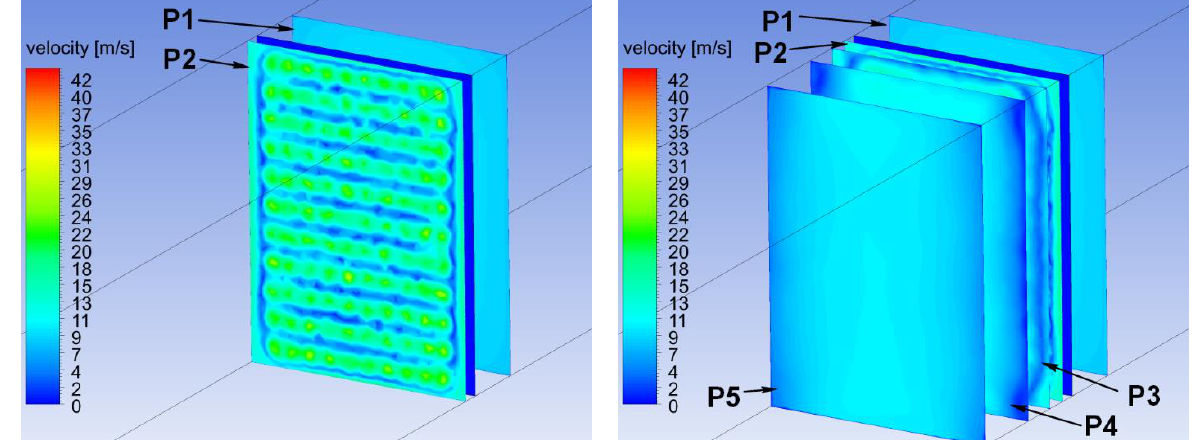
9 of 21 Figure 3. Pathlines inside the tunnel for Δ p BC = 145 Pa.